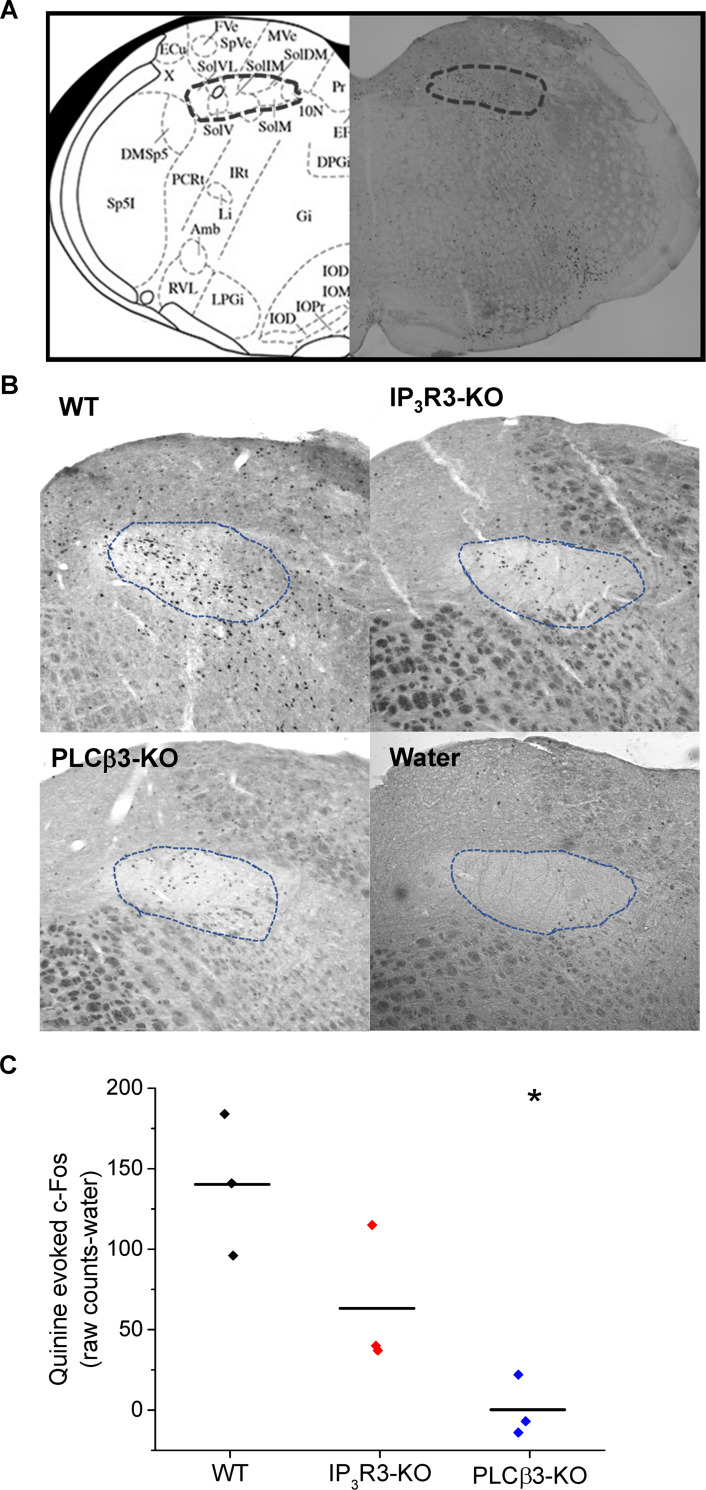
Loss of PLCβ3 or IP3R3 causes deficits in the taste-evoked neural activity in the nucleus of solitary tract.Oral infusion of bitter (quinine) and water elicited c-Fos-like immunoreactivity (FLI) in the intermediate rostral nucleus of the solitary tract (IRNTS). A) The schematic diagram indicates the approximate region in the hindbrain that was analyzed. B) The boundaries of the NTS were delineated for each subject and the relative FLI to quinine for each genotype were compared. Loss of either PLCβ3 (PLCβ3-KO) or IP3R3 (IP3R3-KO) caused a reduction in the FLI in the IRNTS compared to WT mice. C) For all experiments, 3 mice of each genotype were used and data were normalized to the water control. Each data point is plotted and the average values are indicated with a black line for each genotype. Data were analyzed with a one way ANOVA with follow up Fisher’s post-hoc analyses to identify individual differences. Significance level was set at p<0.05 (*).